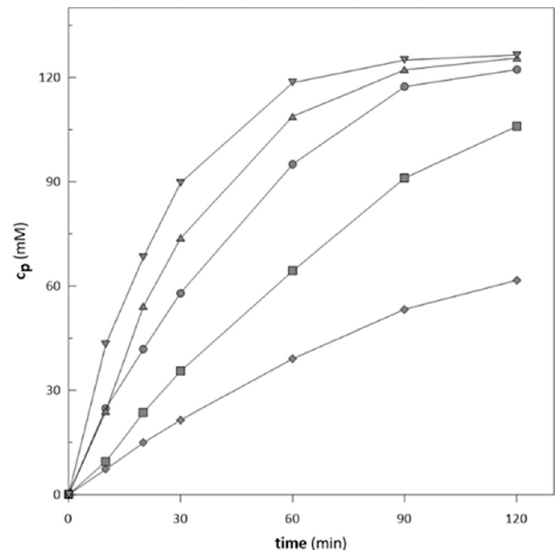
Figure 5. Biotransformations of ethyl-2-methyl acetoacetate at different cofactor concentration ( ♦ 10 µM; ■ 25 µM; ● 50 µM; ▲ 125 µM; ▼ 250 µM) with immobilized enzymes.